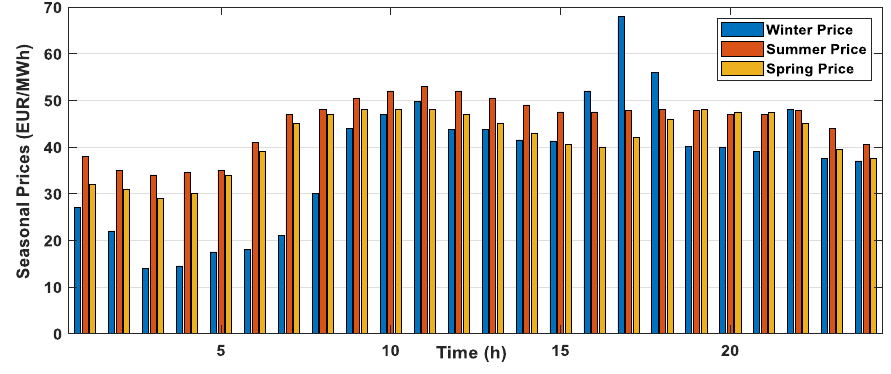
Figure 6. Seasonal prices.